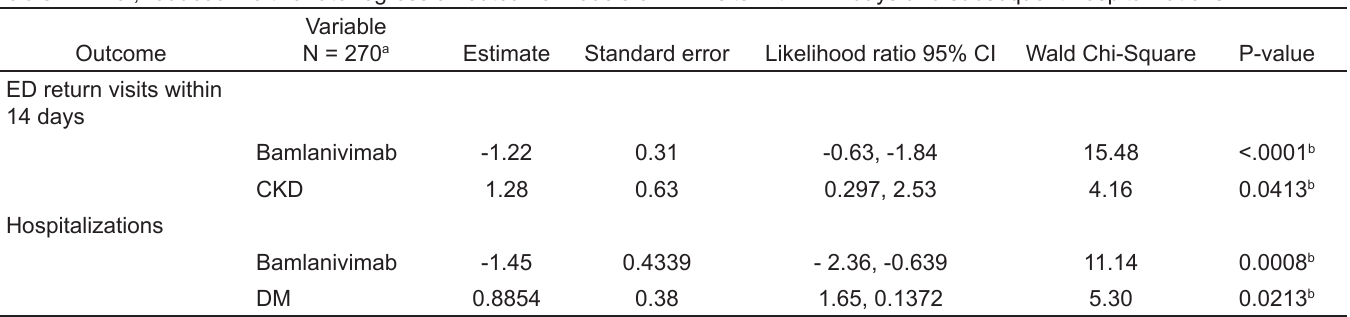
Table 4. Final, reduced multivariate regression outcome models of ED visits within 14 days and subsequent hospitalizations.